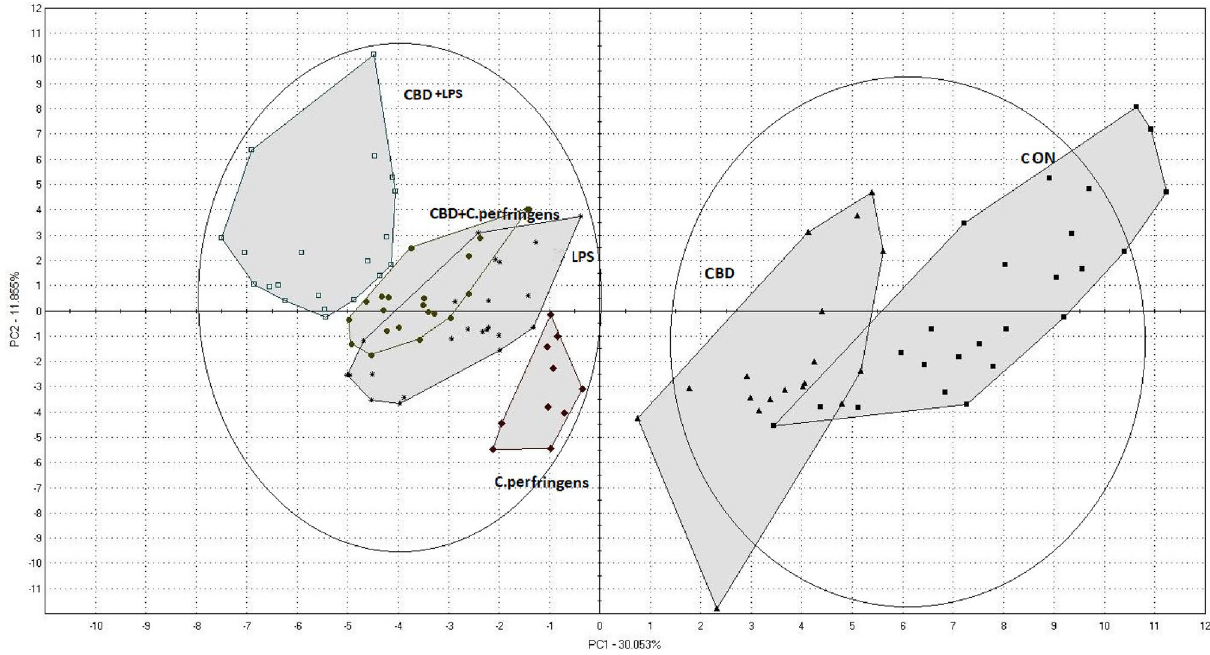
Figure 3. PCA of volatile compounds in chicken breast meat. CON: received the basal diet over the entire period of the experiment and no challenge; CBD: received the CON diet supplemented (on top) with 30 g/kg Cannabis sativa extract; C. perfringens and LPS: received the CON diet and subjected to C. perfringens and E. coli LPS challenge, respectively; CBD + C. perfringens and CBD + LPS: received the CBD diet and subjected to C. perfringens and E. coli LPS challenge,